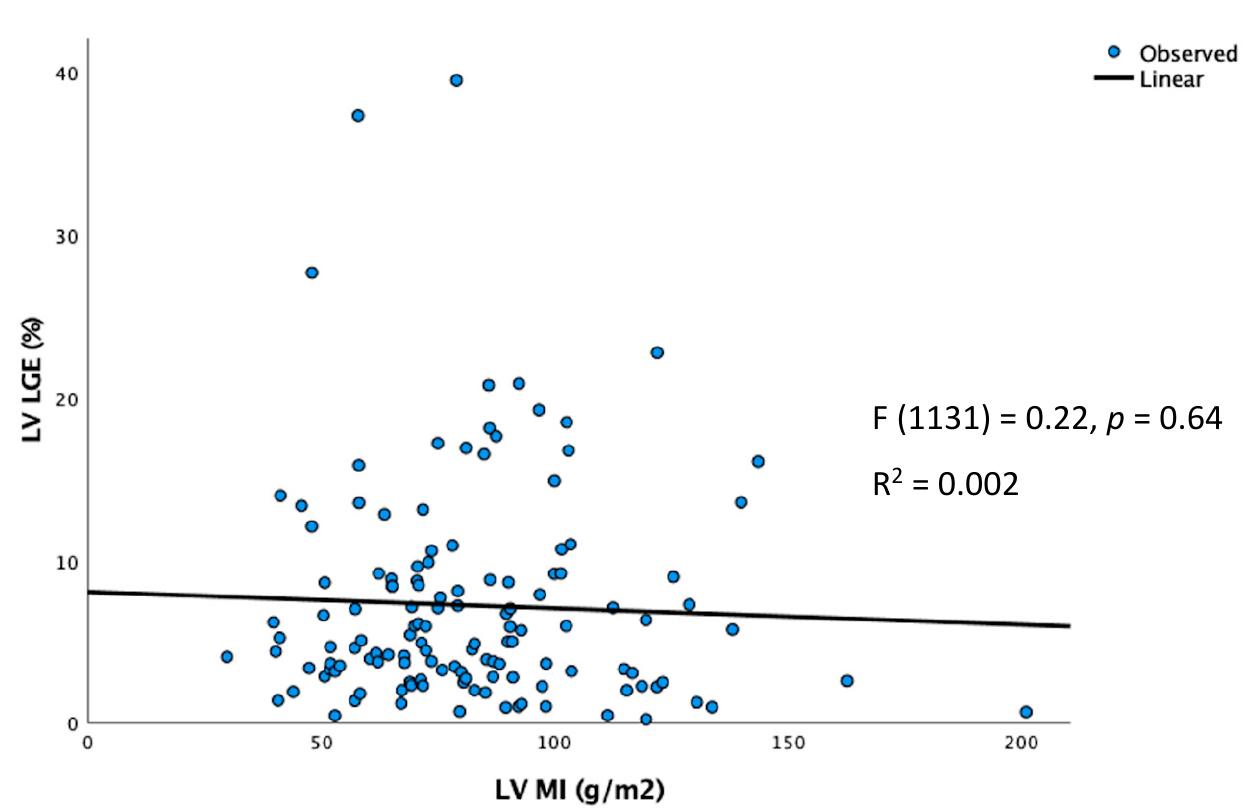
Figure 6. Correlation between LV MI and LV LGE measured using CMR.